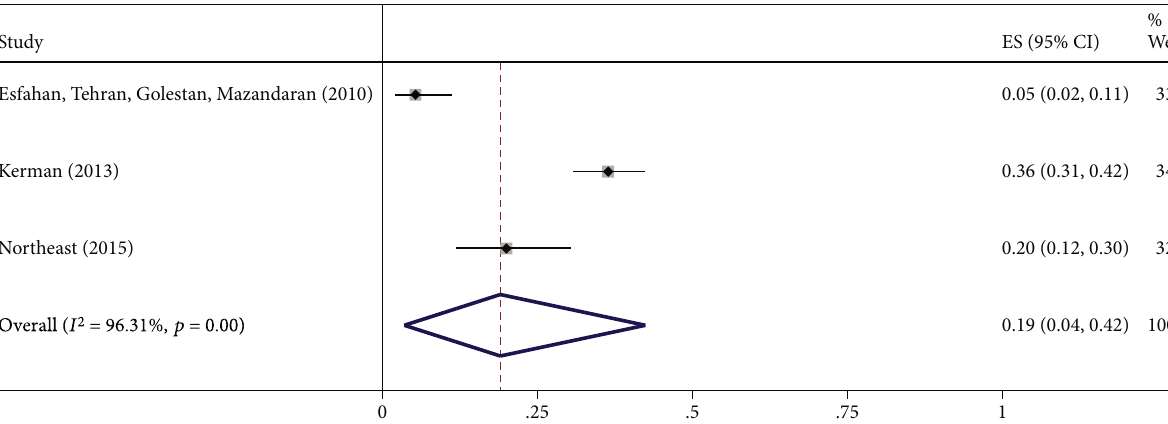
Figure 8: Forest plot of 3 studies on cystic echinococcosis G